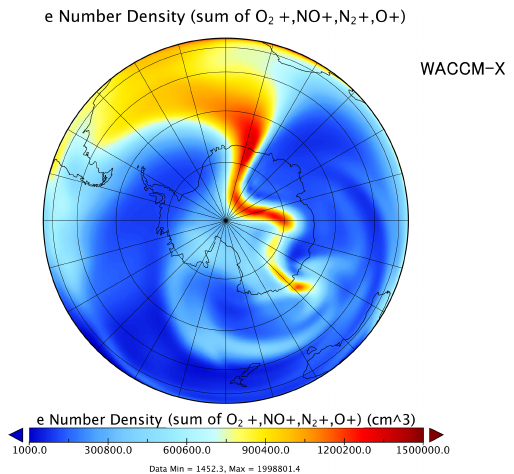
Figure 9. Polar map of the electron density in the Southern Hemi- sphere at 14:00UT on 17 March 2013 from the WACCM-X 1 ◦ sim-